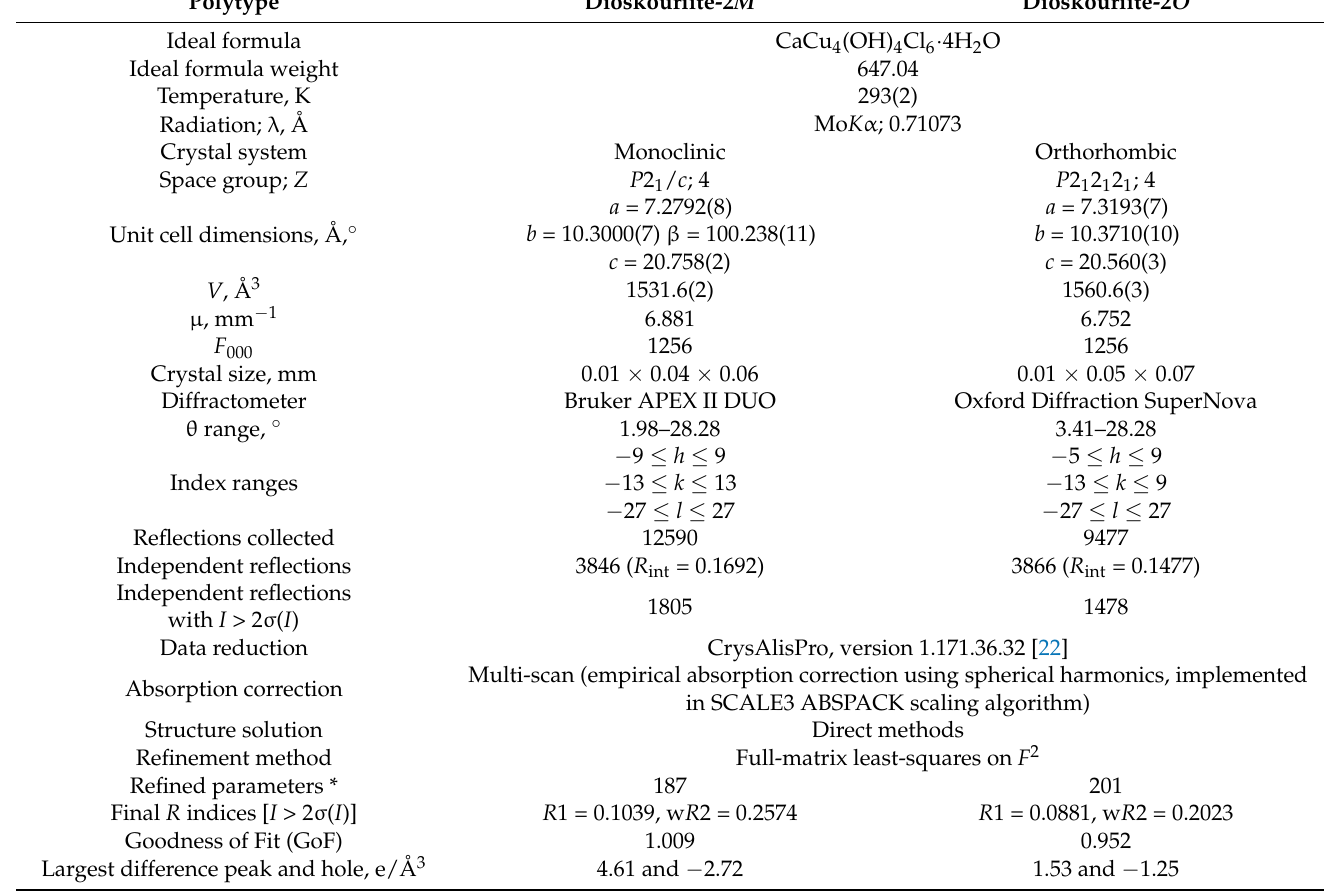
Table 3. Crystal data, data collection information and structure refinement details for dioskouriite-2 M and dioskouriite-2 O